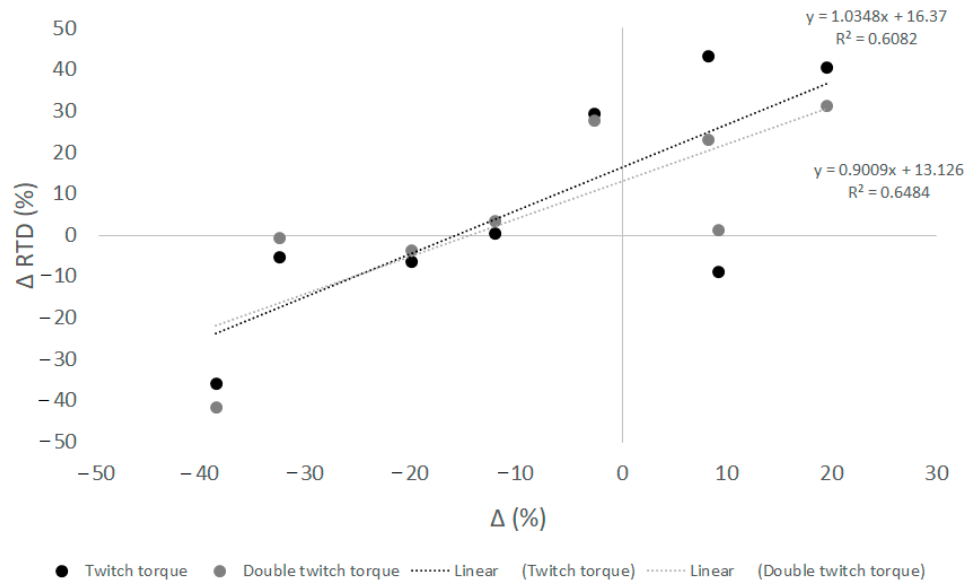
Figure 2. Correlations between relative change in rate of torque development (RTD) of knee extensors and relative changes in T TW (grey circles) and T DB100 (black circles) after explosive and endurance training at moderate altitude.